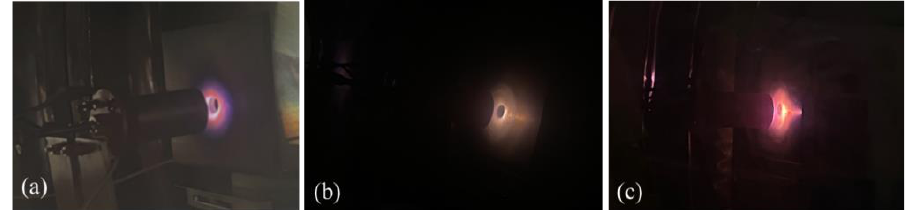
Figure 13. Plasma state variation during the high-current test. ( a ) Violet plasma cone with an anode current of 5 A. ( b ) Fading orange glow, Ia = 15 A, Va = 19 V. ( c ) Bright orange glow, Ia = 15 A, Va = 26 V.